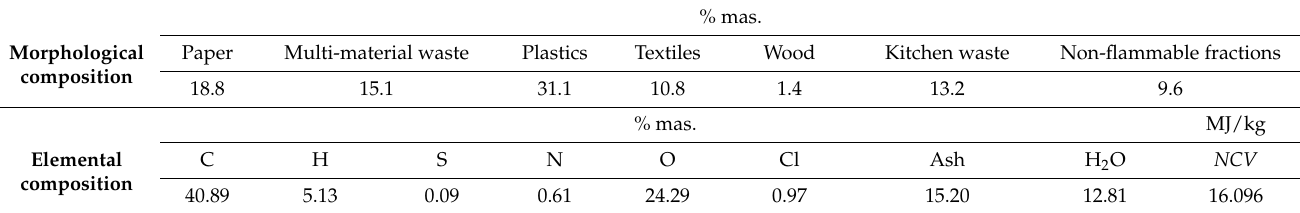
Table 1. Composition of oversieve fraction of waste.